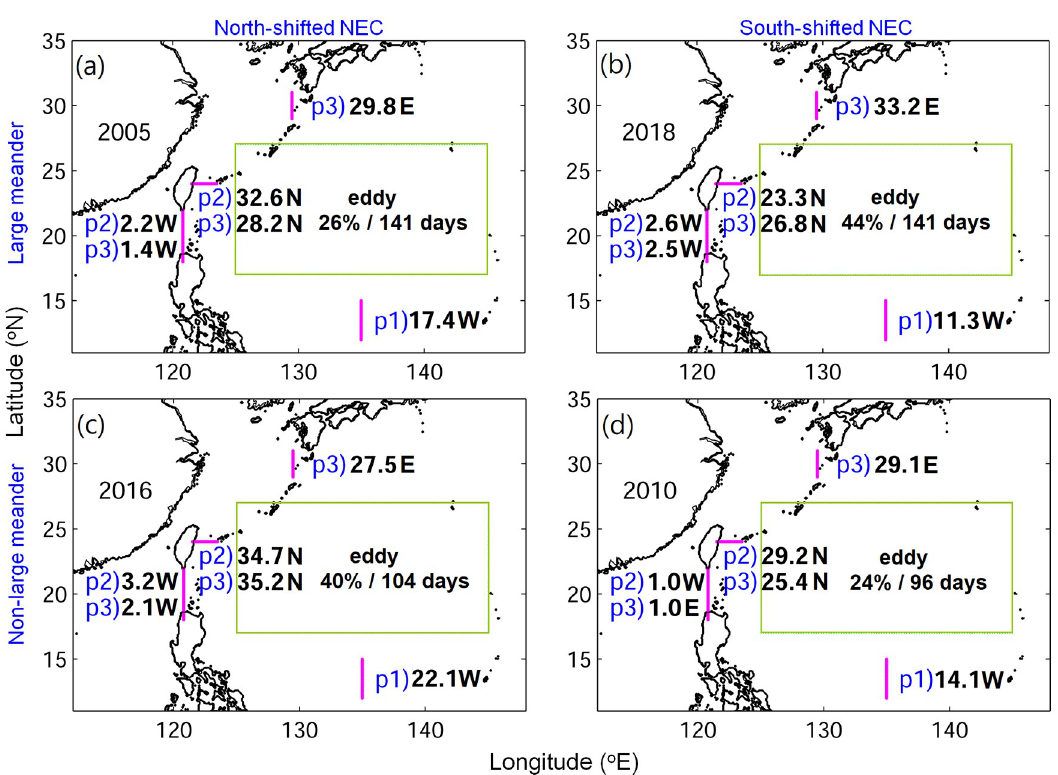
Fig 7. The simulated 50 − 250 m depth-averaged current speeds (cm/s) and eddy presence (percentage of eddies and average days of retention within the green box) at the corresponding periods of v-larvae passing through. Period 1 (p1) is early migration from May to October, period 2 (p2) is early recruitment from November to coming January, and period 3 (p3) is late recruitment from February to April. Magenta lines indicate the sections used for calculating mean velocity. N, W, and E next the numbers indicate the current flow directions of northward, westward, and eastward,